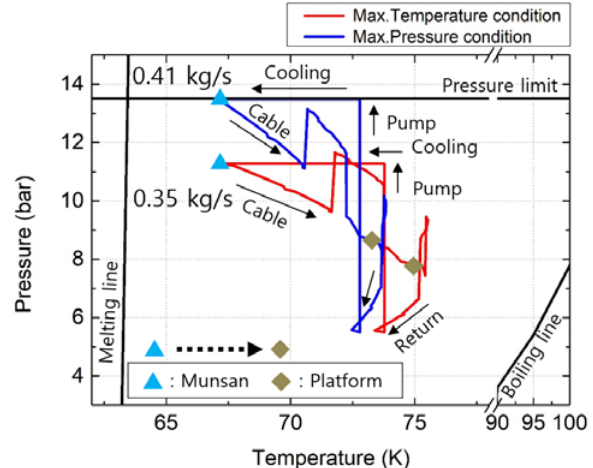
Figure 13. Possible operating range between pressure and temperature limit with internal return path in phase diagram, Munsan to platform.